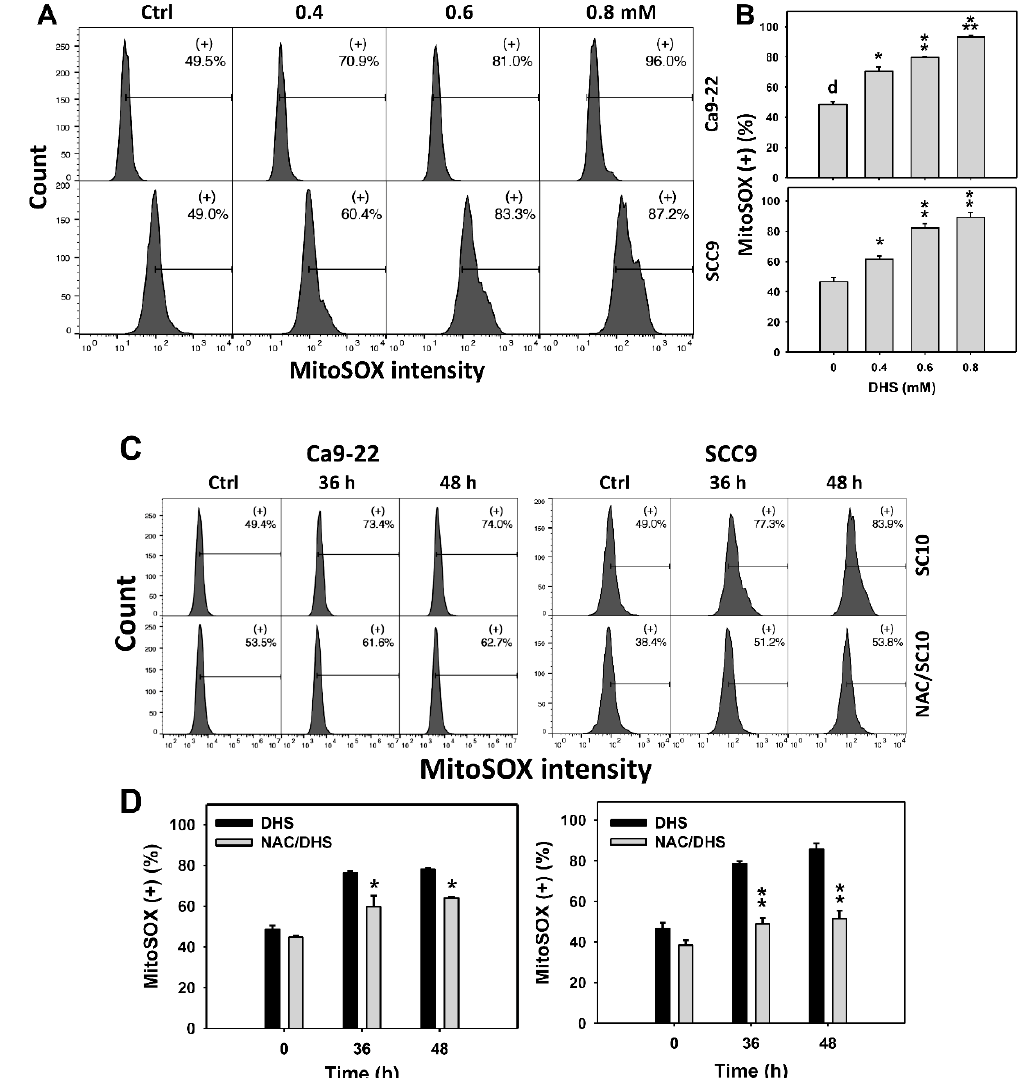
Figure 6. DHS effects on MitoSOX contents of oral cancer cells. ( A , B ) Representative MitoSOX patterns of DHS-treated oral cancer cells. Cells (Ca9-22 and SCC-9) were treated with 0.4, 0.6 and 0.8 mM DHS or vehicle (containing 0.08% DMSO) for 48 h. (+) indicates the high MitoSOX populations. ( C , D ) Alleviation of the MitoSOX changes of DHS-treated oral cancer cells by NAC. Cells were pretreated with NAC (4 mM, 1 h) or not, and then they were treated with 0.6 mM DHS or vehicle for 0, 36, and 48 h. Data = means ± SDs ( n = 3 independent experiments). *, ** and *** indicate significant differences between ( A , B ) DHS and control and ( C , D ) DHS and NAC/DHS ( p < 0.05, 0.01 and 0.001, respectively). A positive control for MitoSOX generation of oral cancer cells is provided in Supplementary Figure